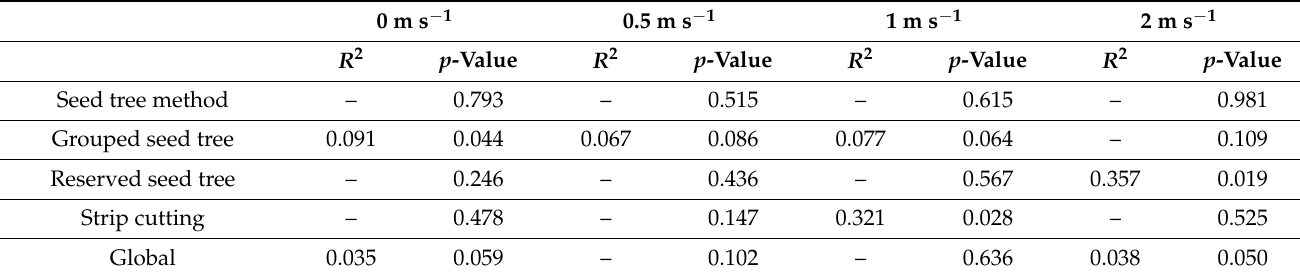
Table A2. Simple linear regressions between spatial patterns of predicted and observed seed dispersal by applying different wind speeds threshold (0, 0.5, 1, 2 m s − 1 ) and by natural regeneration patches. A dash indicates a statistically insignificant R 2 ( p >